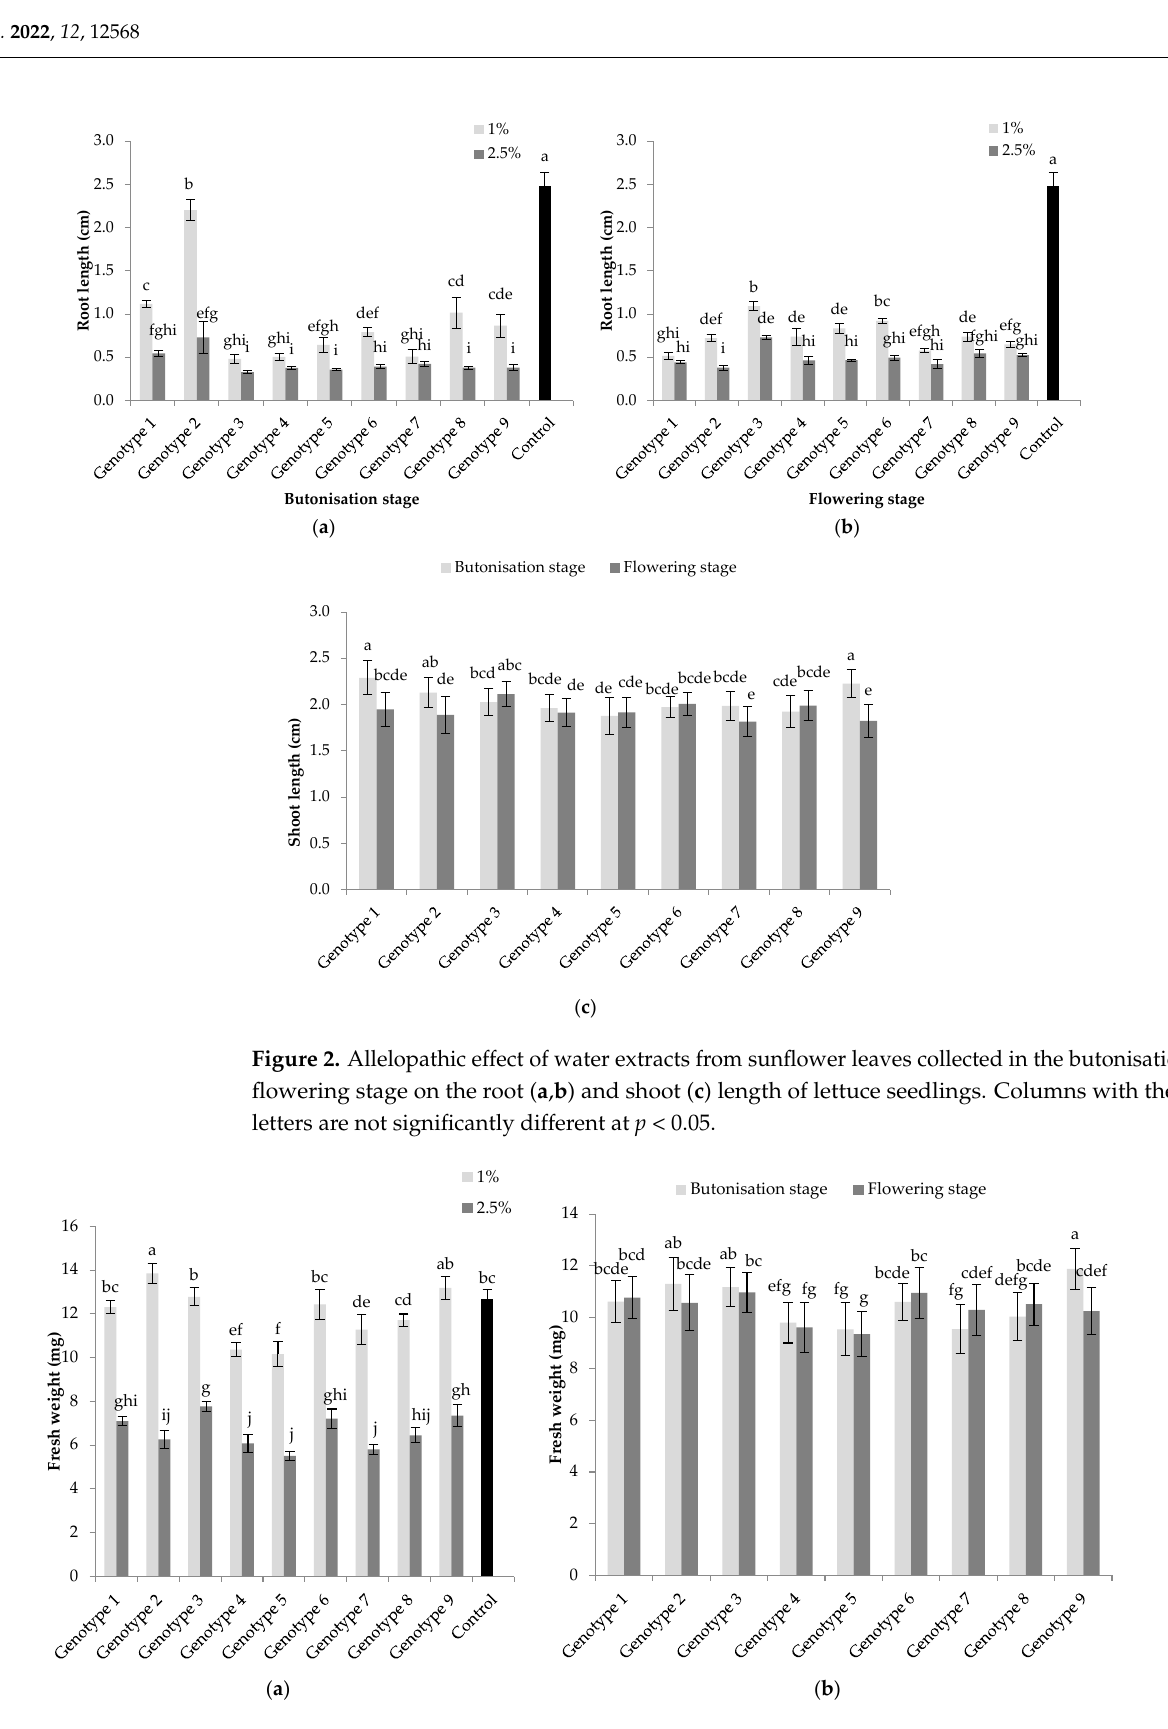
Figure 3. Allelopathic effect of water extracts from sunflower leaves on the fresh weight of lettuce seedlings: ( a ) “concentration × genotype” and ( b ) “growth stage × genotype” interactions. Columns with the same letters are not significantly different at p < 0.05.